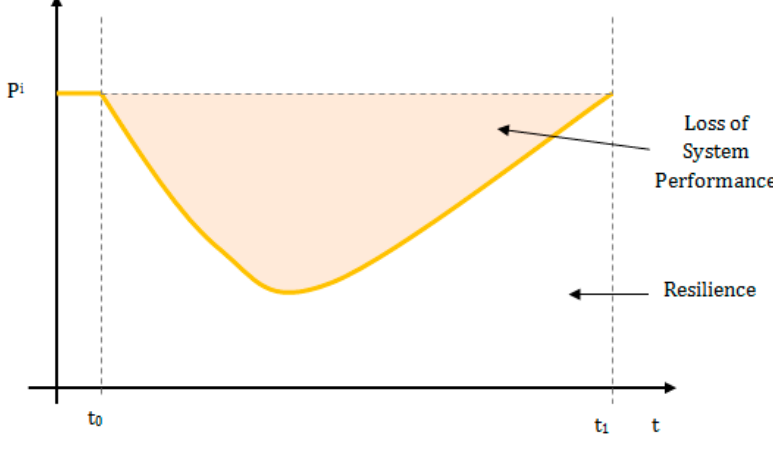
Figure 2. Sample of a dynamic measure of system performance.